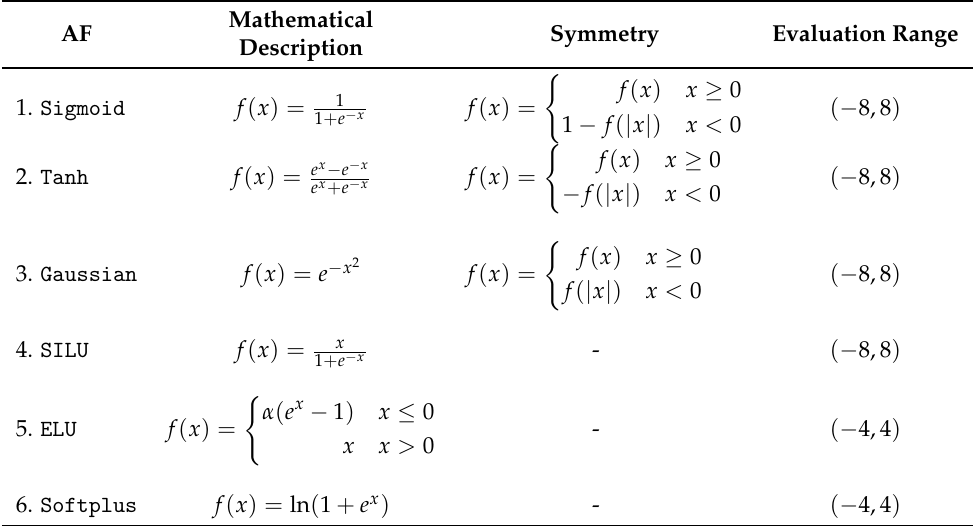
Symmetry Evaluation